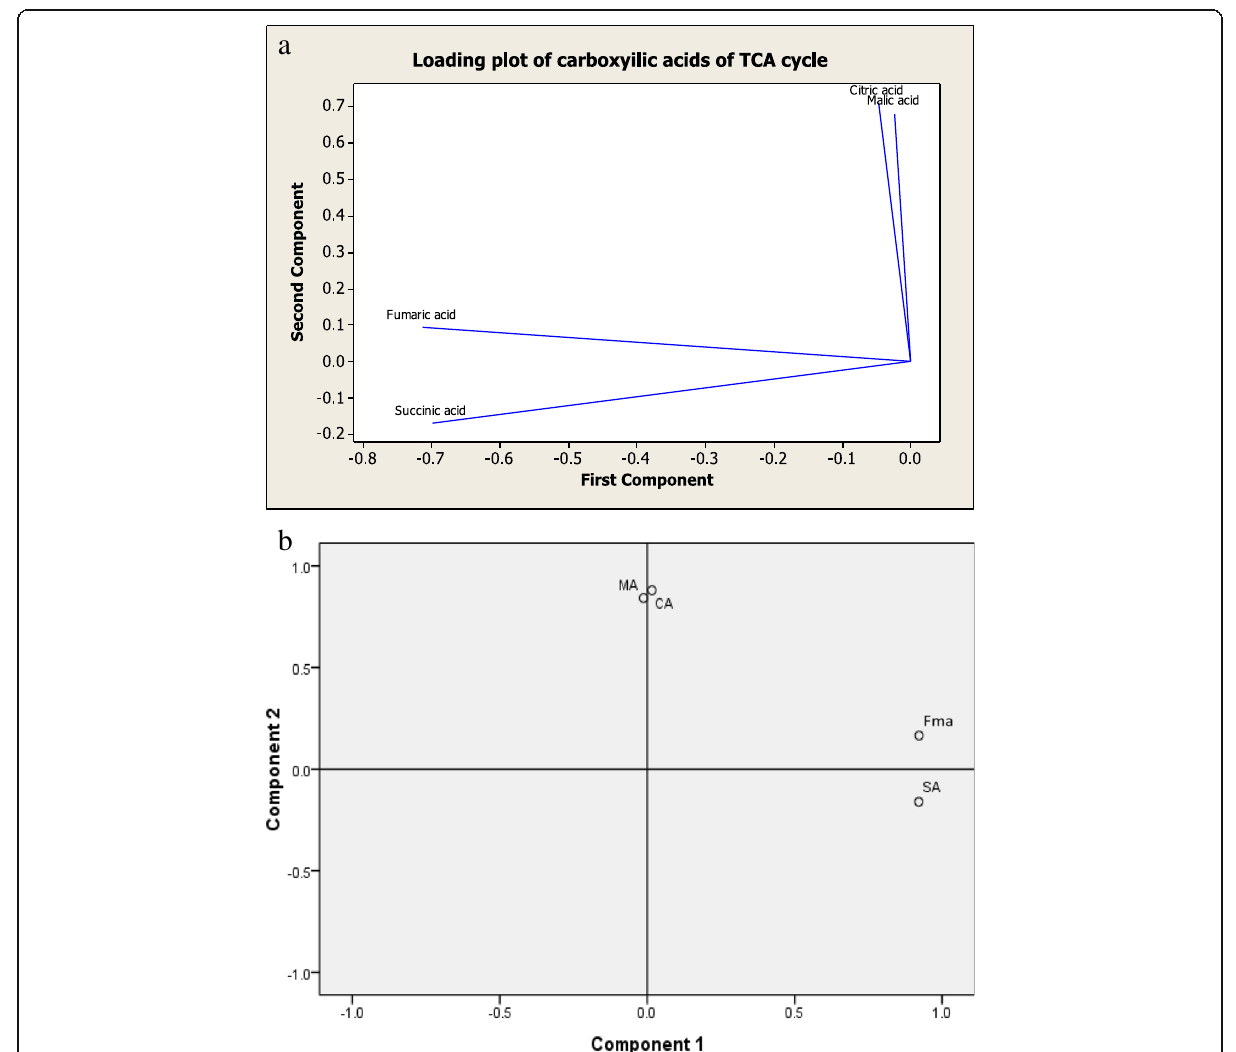
Fig. 2 a Loading plot of PCA for intermediate acids (SA and FmA) and source-sink acids (CA, MA). b Score plot of PCA for intermediate acids (SA and FmA) and source-sink acids (CA, MA)